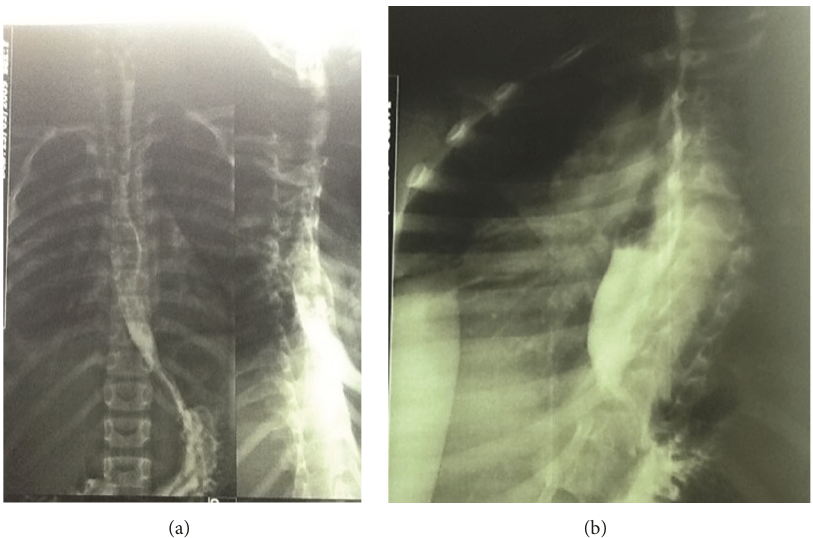
Figure 8: (a) and (b) Esophagogram of the girl 2 months after surgery. There are no leaks. The esophagus appeared normal.